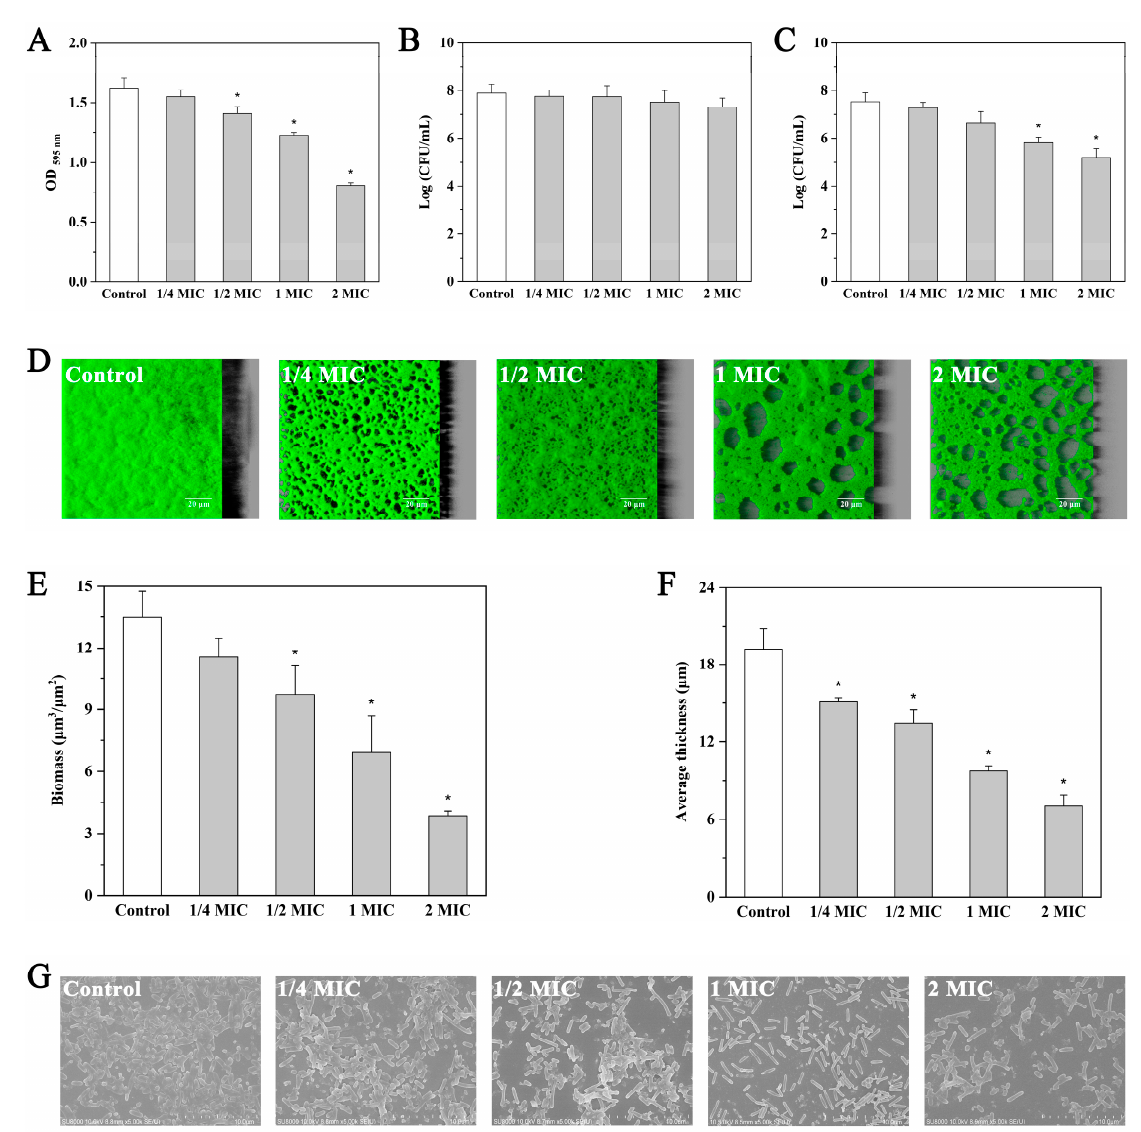
Figure 4. Effect of andrographolide on preformed biofilms. ( A ) Biofilm assay by microtiter plater with crystal violet staining. ( B ) Surviving cells in biofilms. ( C ) Surviving planktonic cells in the bacterial culture. ( D ) CLSM images. ( E ) The biofilm biomass of CLSM analysis. ( F ) Mean thickness of biofilm by CLSM analysis. ( G ) SEM images. Error bars represent the standard deviation of triplicate experiments ( n = 3). The asterisk indicates a value statistically different from that of the control, with p <